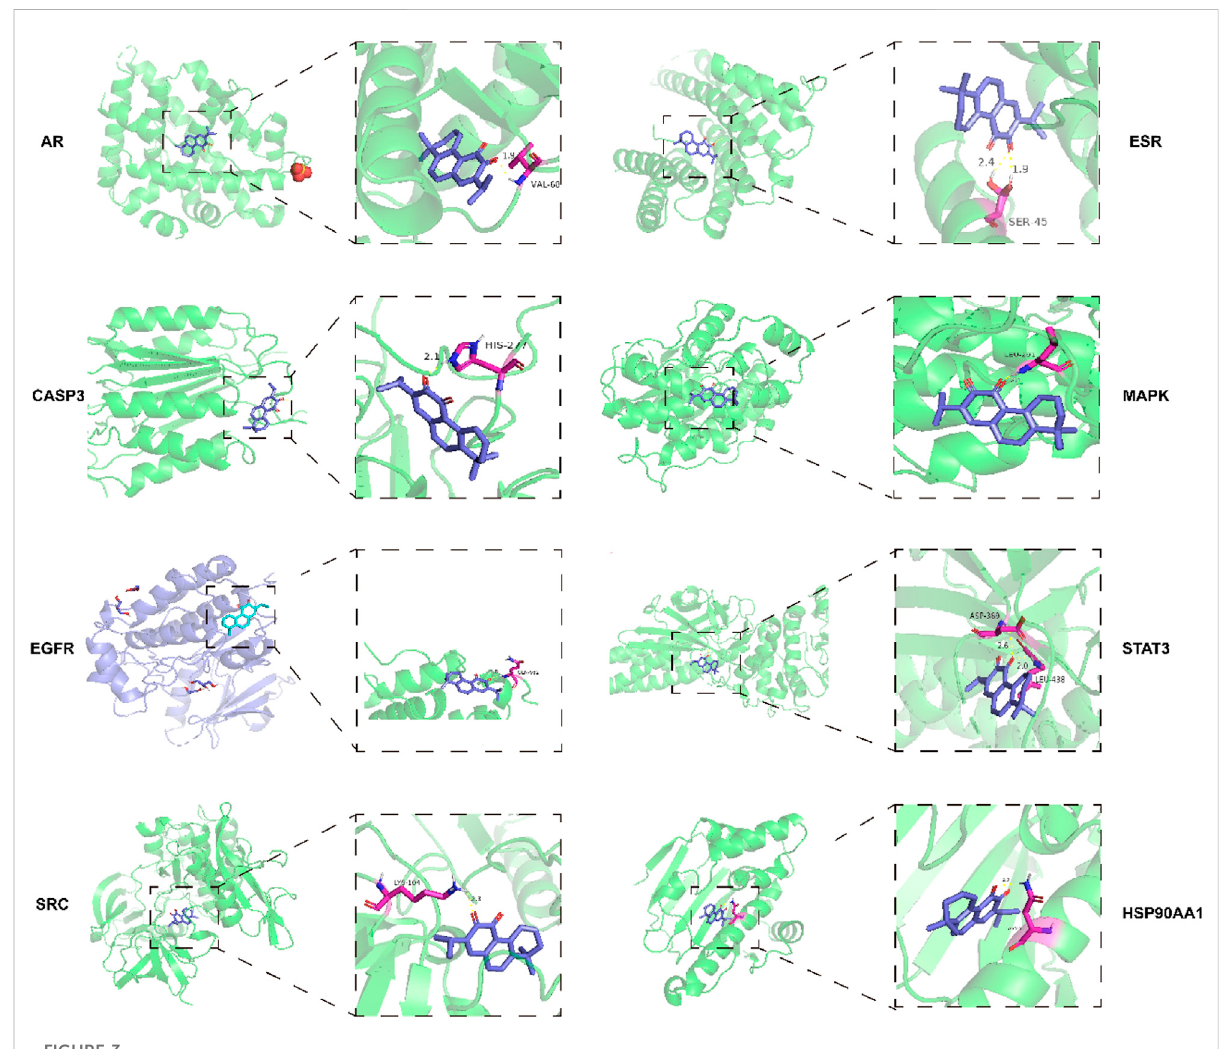
FIGURE 3 DHT docking with the core target